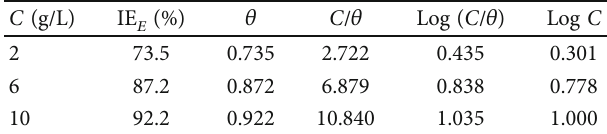
Table 5: Langmuir isotherm